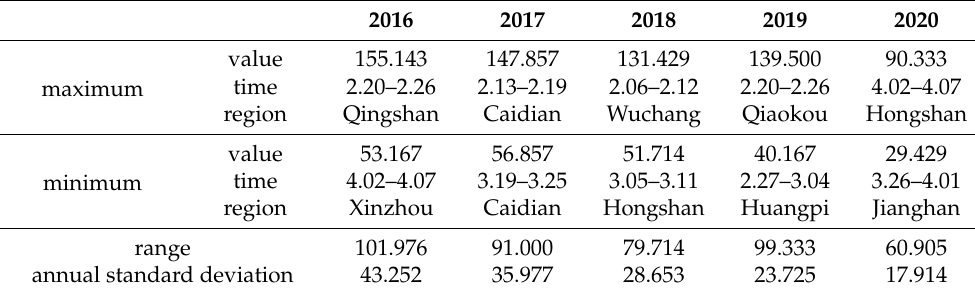
Table 3. AQI maximum/minimum statistics from 2016 to